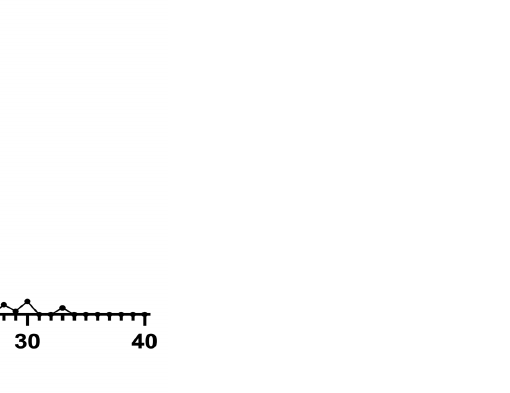
Figure 7. A chromatographic profile of astaxanthin after SEC of an H. pluvialis extract. Astaxanthin was detected at 477 nm. The chromatographic profile is the mean of two chromatographies.